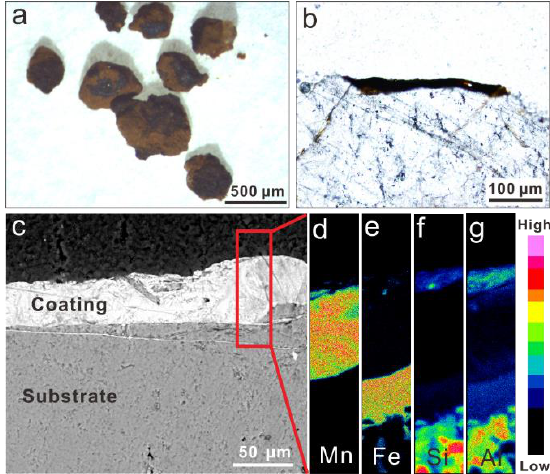
Figure 2. Hand specimen ( a ), optical image ( b ), back-scattered image ( c ) and elemental distribution patterns ( d – g ) of soil Fe/Mn coating. The rectangle in panel ( c ) indicates the EDS mapping region.